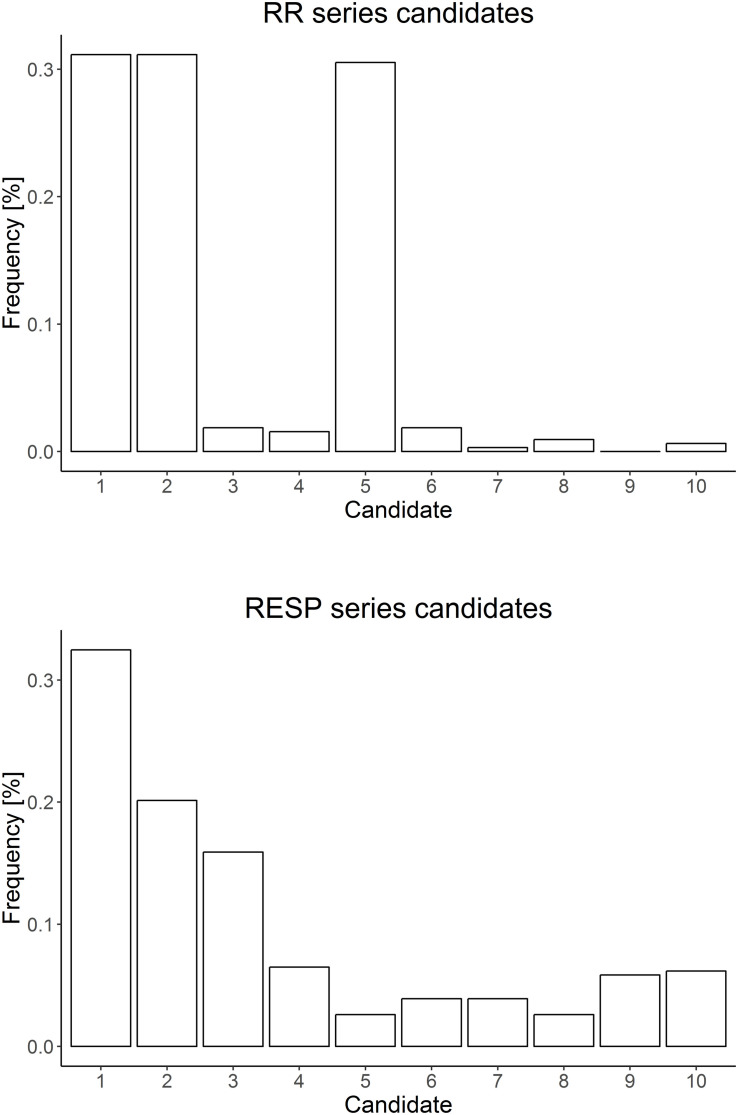
X
(top) and Y
(bottom) series candidate distributions employed for TE computations considering lag = 0. RR series candidate distribution shows a proper selection of the simulated delays. On the other hand, RESP candidate distribution reflects the weak modulation effect of series Y on X.